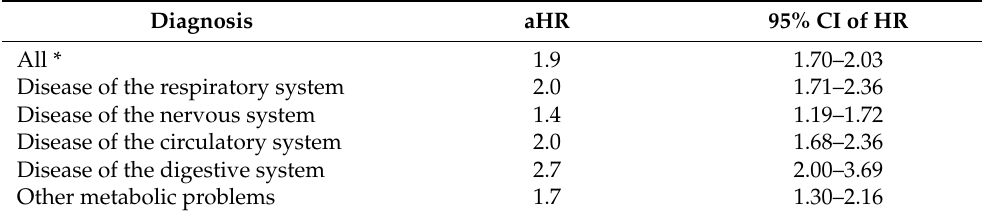
Table 2. The association between DNR order and mortality adjusted for age, sex and comorbidities by Cox regression in different diagnosis